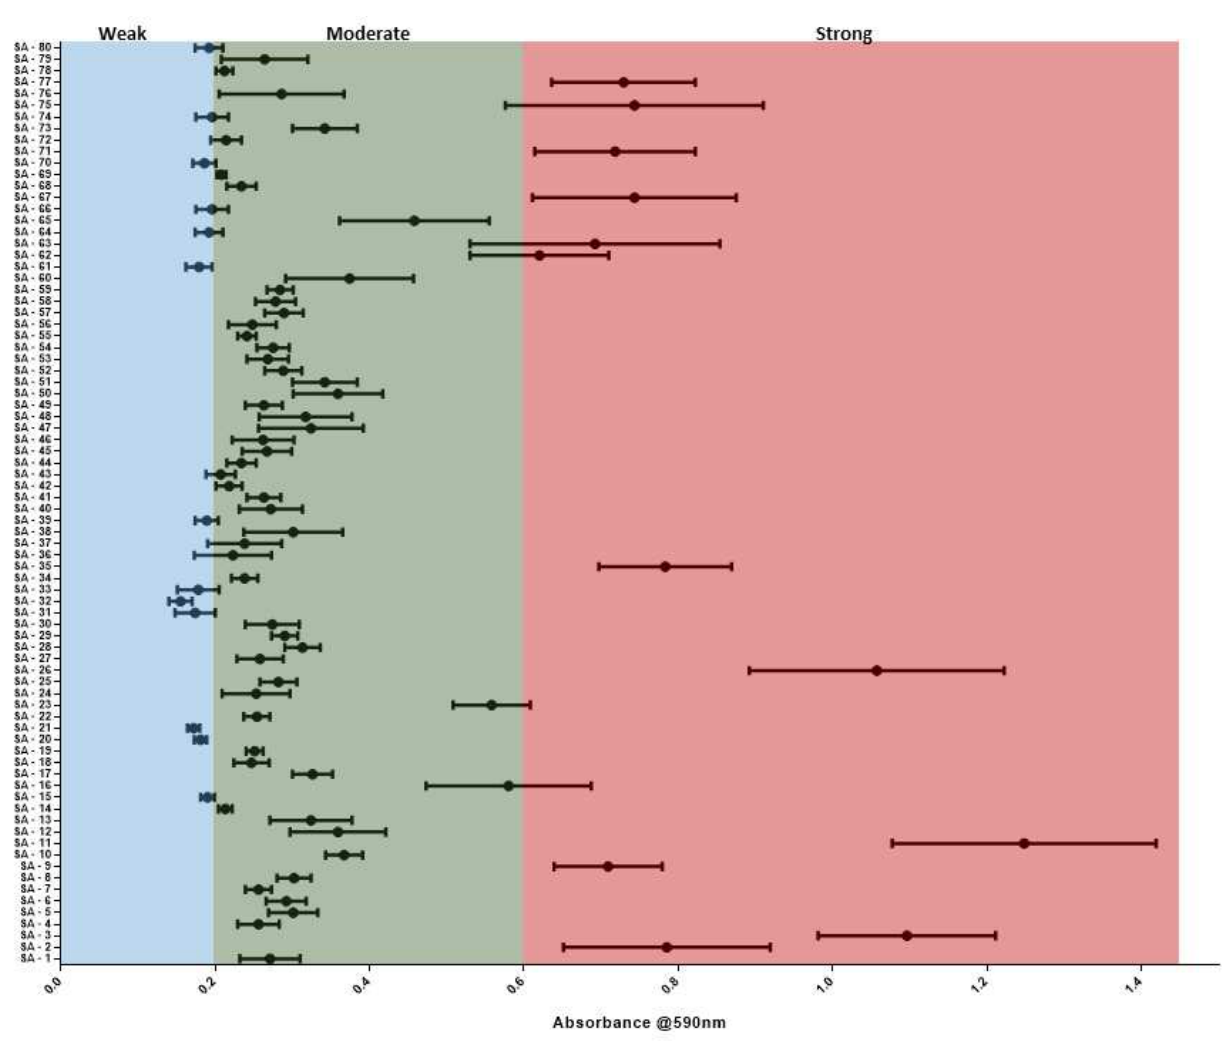
Figure 3. Classification of the biofilm-forming intensity of S. aureus isolates: The biofilm formation ability was determined using the crystal violet (CV) method and the biofilm formed was differentiated into strong (red), moderate (green) and weak (blue) biofilms.